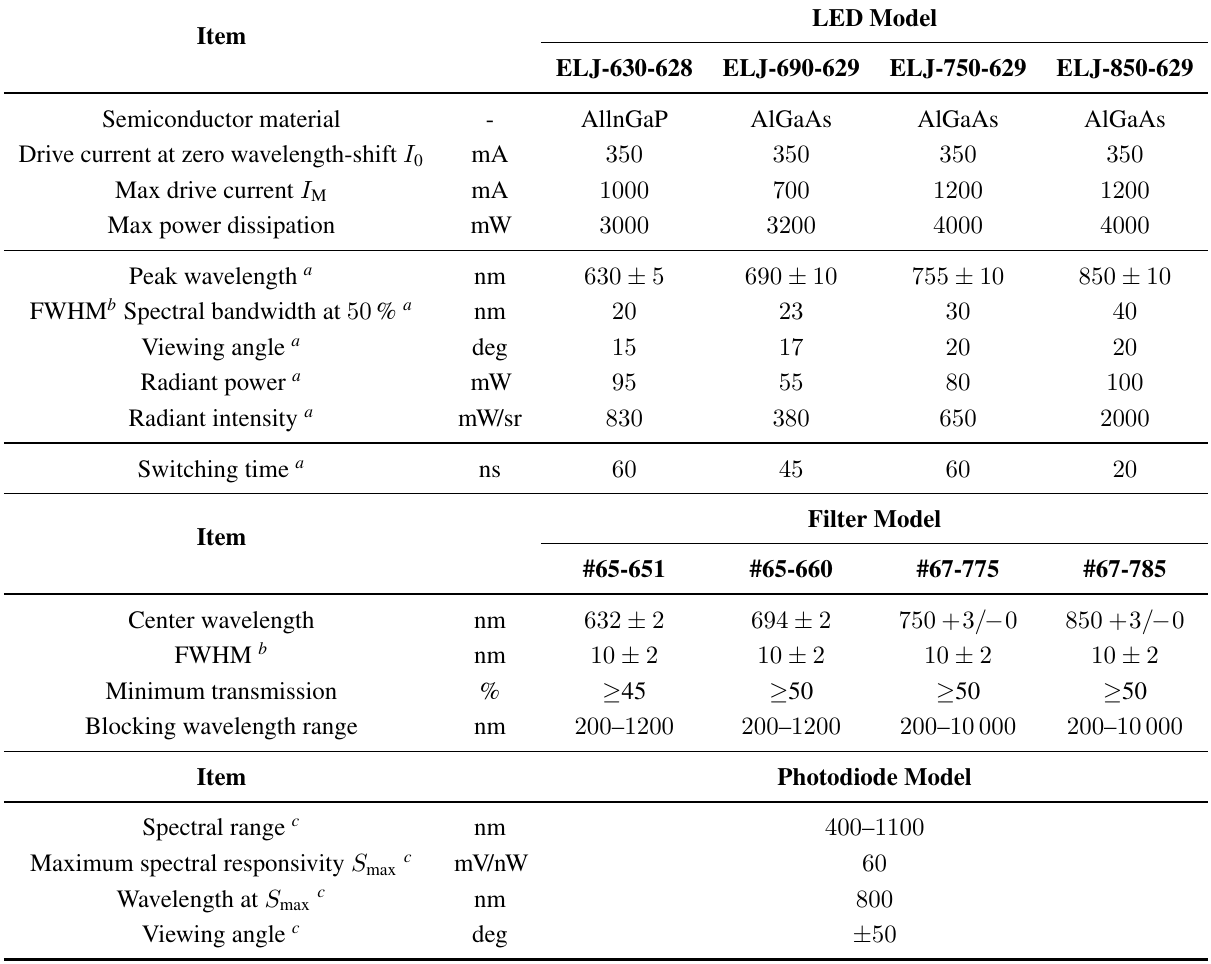
Table 2. Technical data for each measurement channel LED (Roithner Lasertechnik GmbH), filter (Edmund Optics Inc.) and photodiode (Roithner Lasertechnik